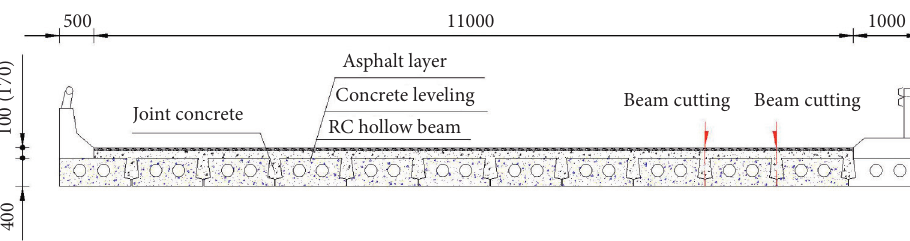
Figure 2: Cross section of the original bridge (unit: mm).